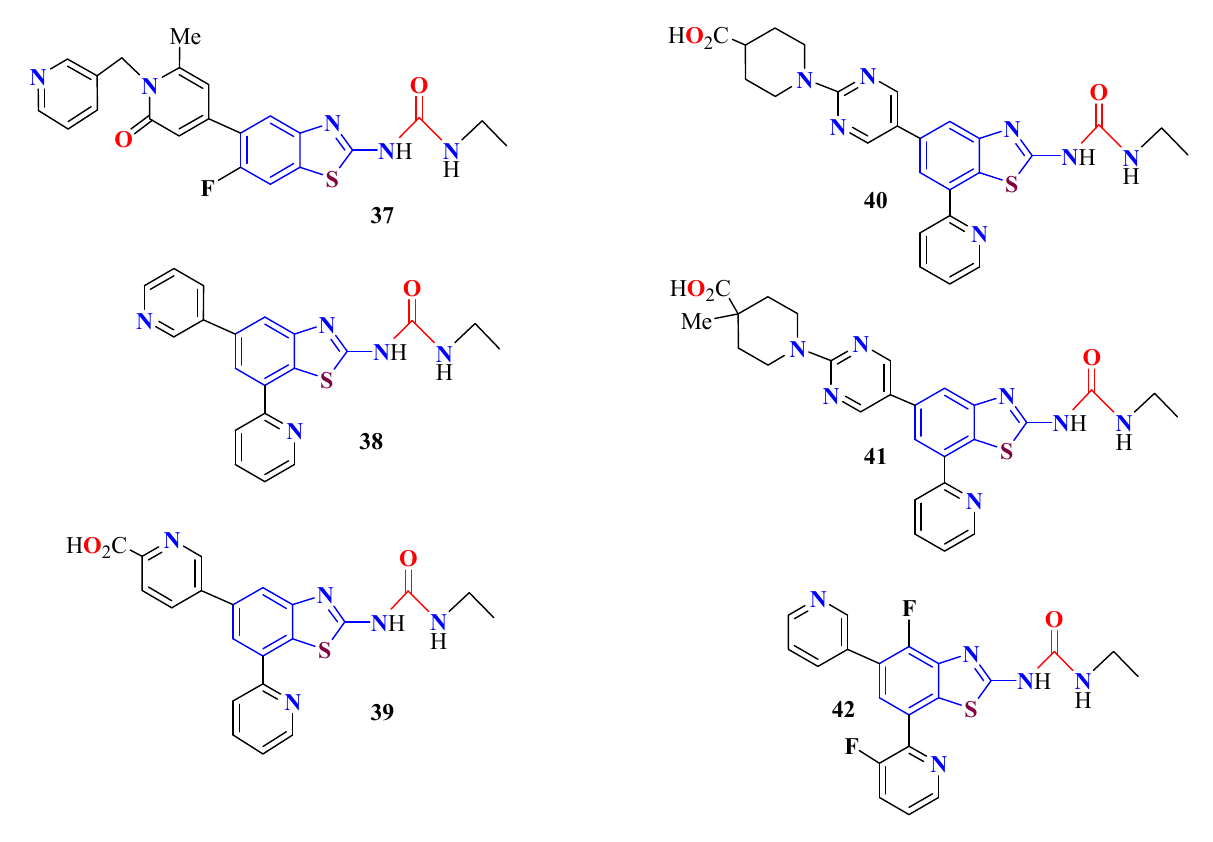
Figure 7. Di- and tri-substituted ethyl-UBTs 37 – 42 from 5,6-, 5,7-, or 4-F,5,7-dihalogenide ethyl-UBTs derived from the corresponding 2ABT and ethyl-isocyanate.